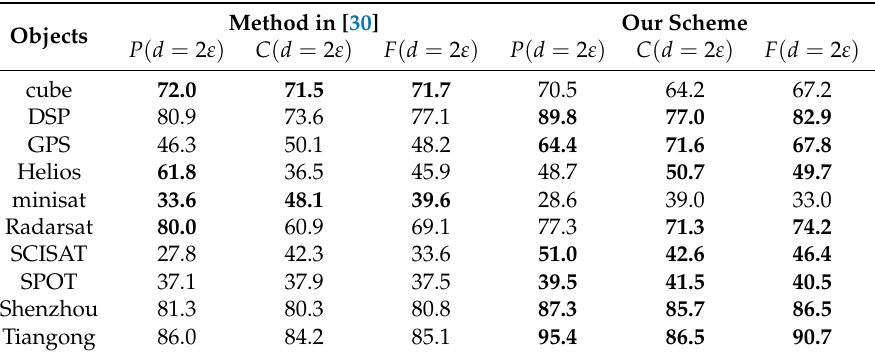
Table 2. Accuracy evaluation of the generated geometric